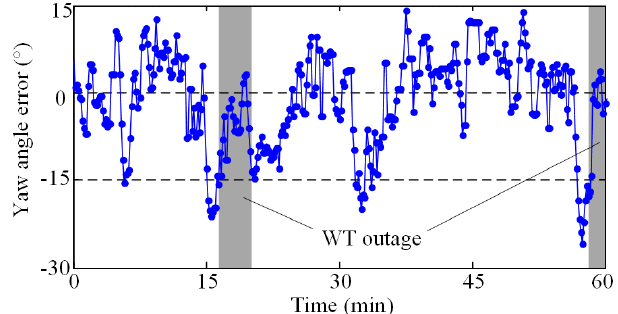
Figure 18. Time series of yaw angle error.